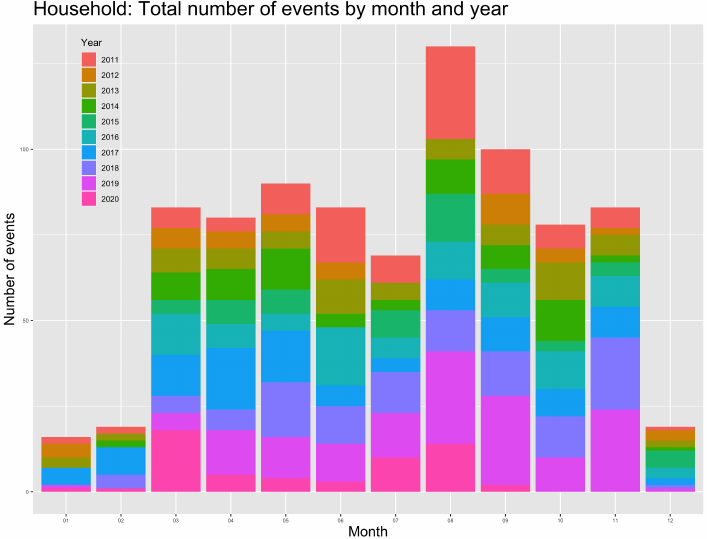
Figure 2. Number of events by month and year per household at USD 150 strike price.